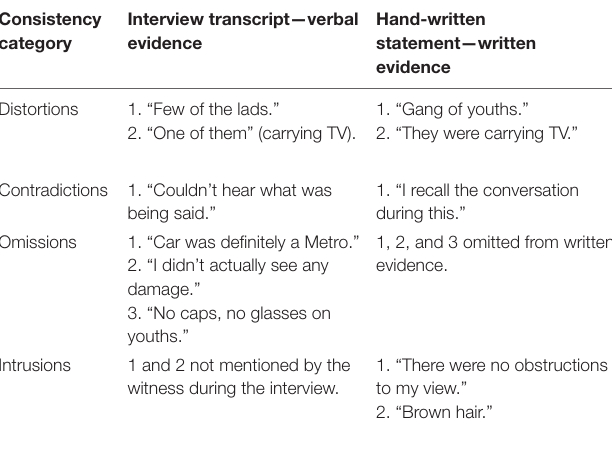
TABLE 2 | Examples of discrepancies across the interview transcripts and hand-written